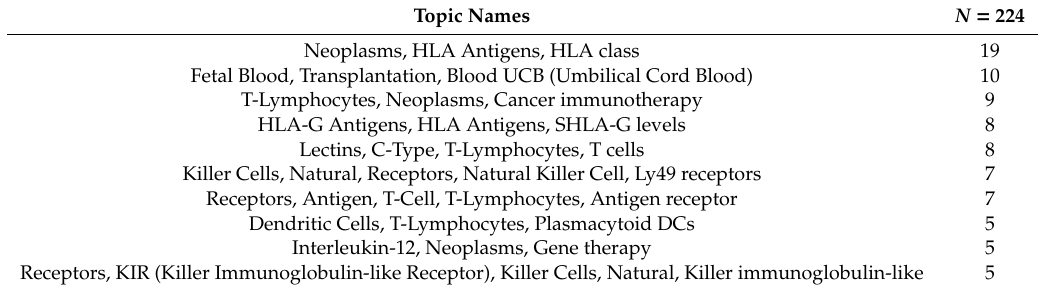
Table 9. Human leukocyte antigen (HLA). Cluster (5), weigh 7.74%.